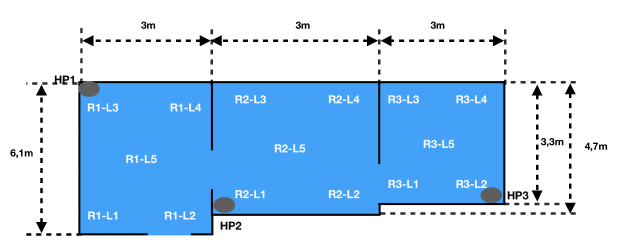
Figure 2. The setup of study 1 showing three home nodes (HP1, HP2, HP3) mounted in each room (R1, R2, R3) with additional indication of five locations (L1, L2, L3, L4, L5) in every room from where the measurements were gathered